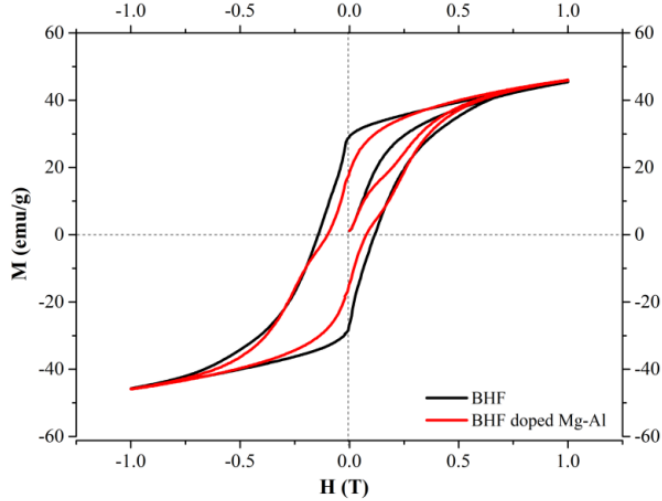
spins. The substitution of the Fe 3+ ions may result in different variations in the magnetic properties of the substituted Ba hexaferrite.